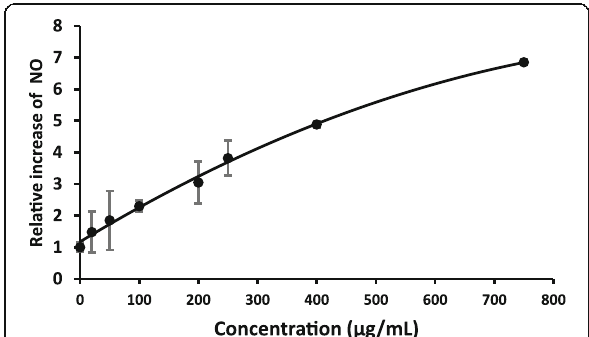
Fig. 5 Increase in nitric oxide levels at different concentrations of Semecarpus parvifolia leaves against HEp – 2 cells (mean ± SD; n = 3). Nitric oxide content of the treated cells relative to that of untreated cells was used to calculate the relative increase of NO